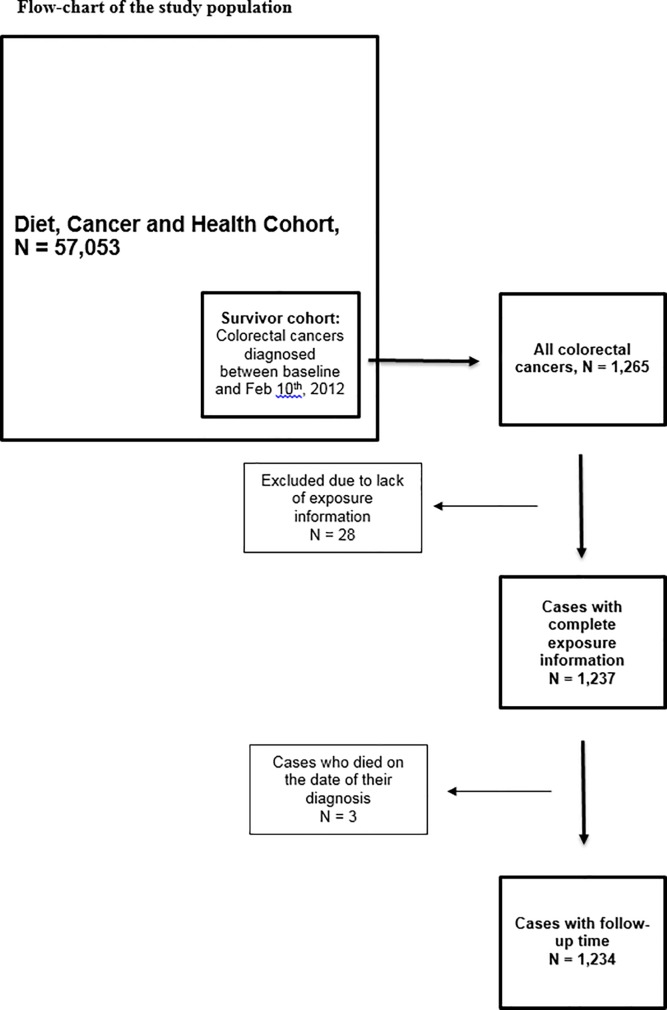
Flow-chart of the study population.